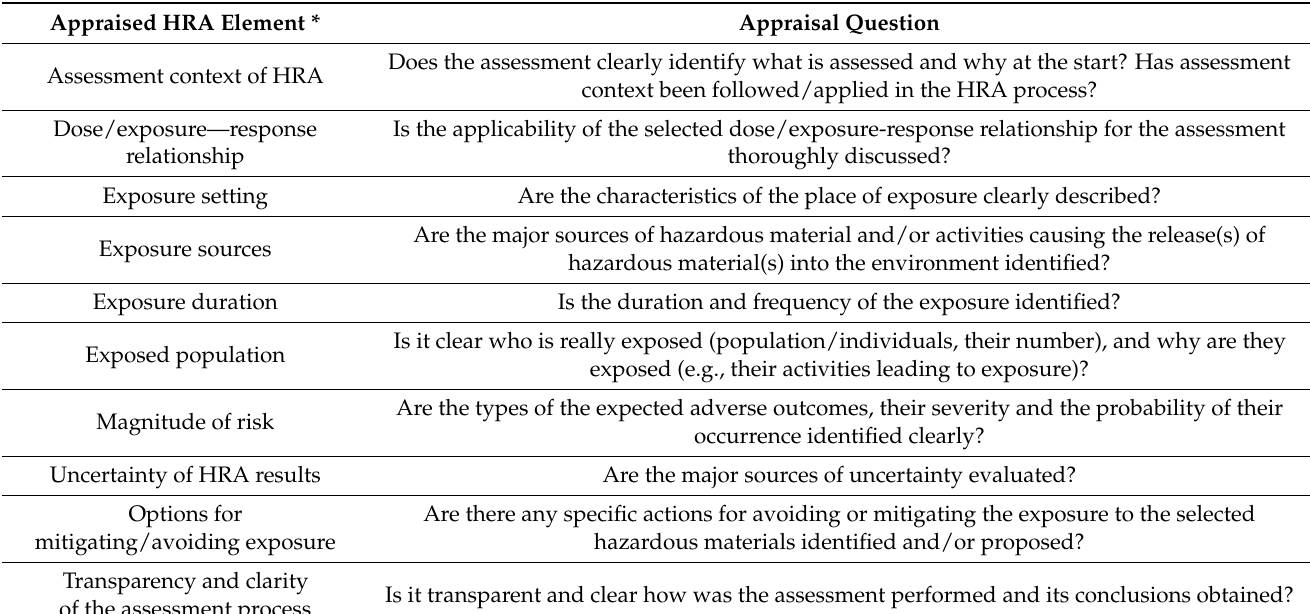
Table 1. Selected health risk assessment (HRA) elements for the appraisal and related appraisal